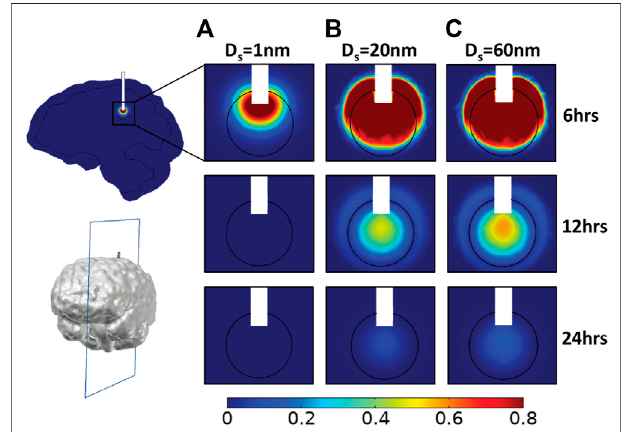
FIGURE 2 | Simulated drug concentration using baseline tumor microenvironment conditions. A sagittal view in the center of tumor tissue showing the spatial distribution of drug concentration and for different diameters of the therapeutic agent, D s : (A) 1 nm, (B) 20 nm, and (C) 60 nm at three time points: 6, 12, and 24 h. Drug concentration is normalized by division with the reference value entering the catheter.